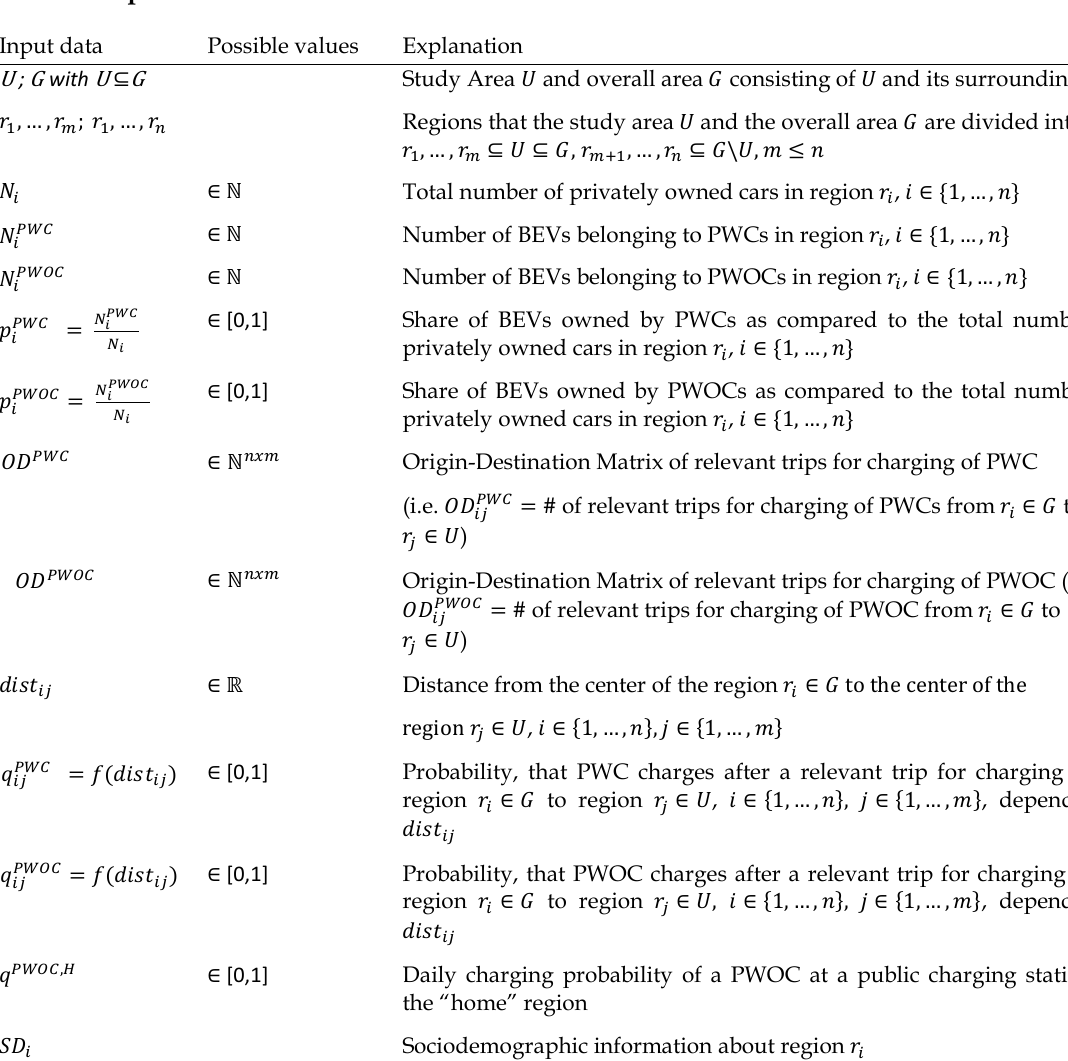
Table 2. Input data for our